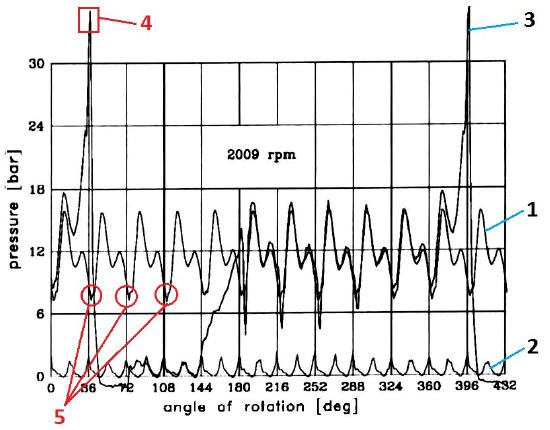
Figure 4. Pressure pulsations in a hydraulic system with a gear pump: 1—discharge pressure, 2—suction pressure, 3—pressure recorded by a sensor installed in the gear tooth space, 4—choked volume and 5—pressure undershoot in the discharge area. Data from open-source journal [39].